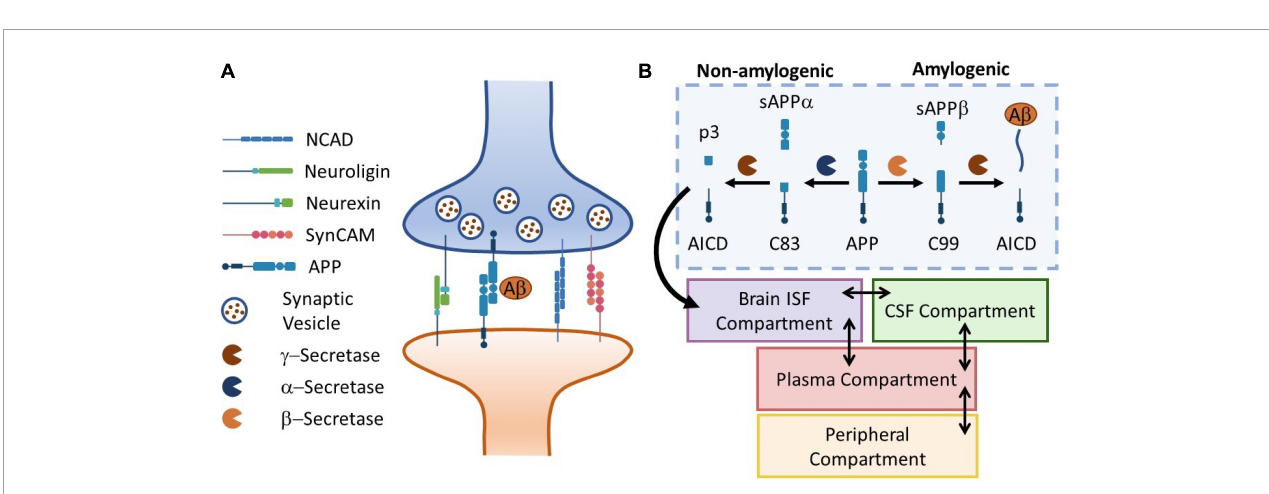
FIGURE2 Panel (A) the schematic representation of a neuronal synapse with four representative families of CAMs. Aß release and kinetics is used to drive the biomarker kinetics model. Panel (B) the APP cleavage pathways in brain ISF diverge in to amylogenic and non-amylogenic braches, depending on the activity of sBACE (ß-secretase) and ADAM10 ( α -secretase), respectively. Here, a simple four-compartment model is used to simulate transport of Aß peptides in the body. Temporal kinetics of synaptic injury biomarkers can be monitored in body fluids (plasma, CSF, saliva, ...